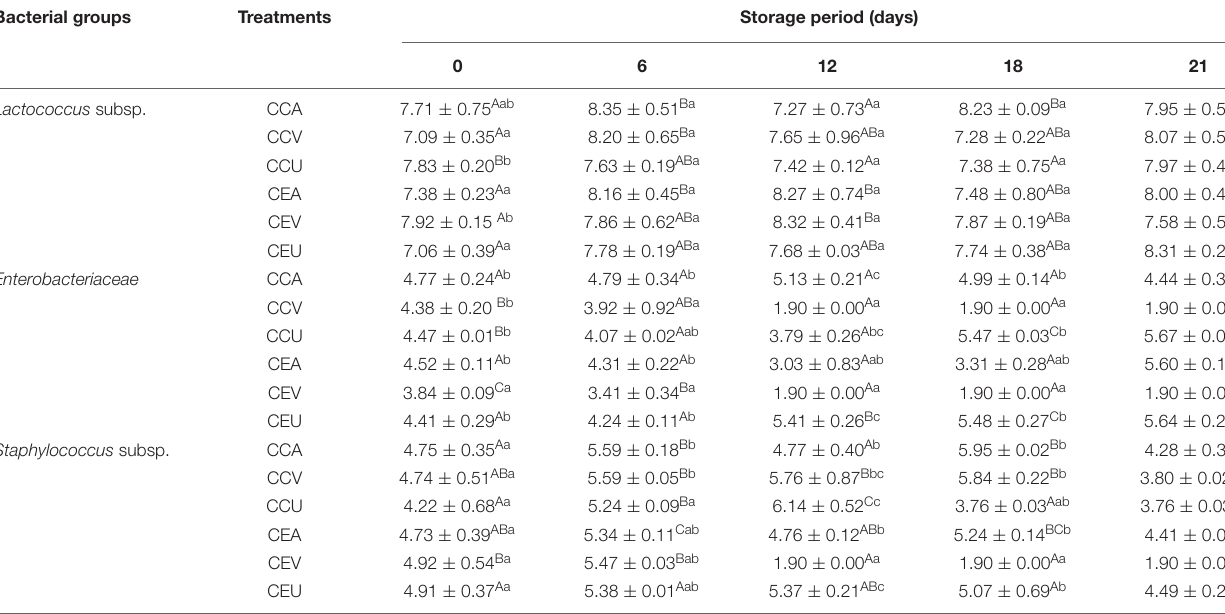
TABLE 1 | Lactococcus spp., Enterobacteriaceae, and Staphylococcus spp. counts (log cfu /g) in raw goat milk cheeses during 21 storage days at 4 ◦ C. Bacterial groups Treatments